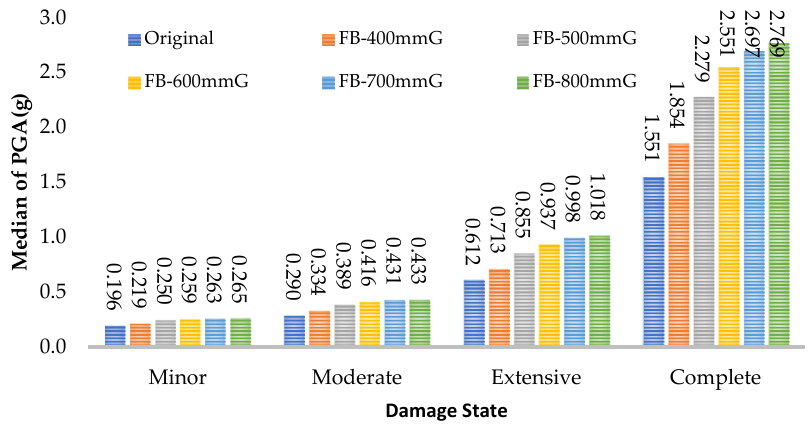
Figure 16. Improvement in the median of PGA in damage states in GFRP flange ‐ bonding frames. Polymers 2023 , 15 , 618